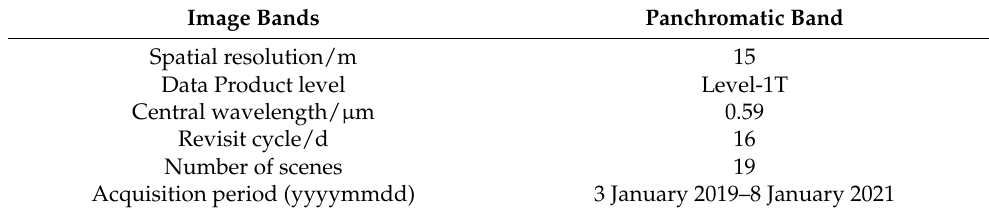
Table 2. Landsat 8 image parameters.